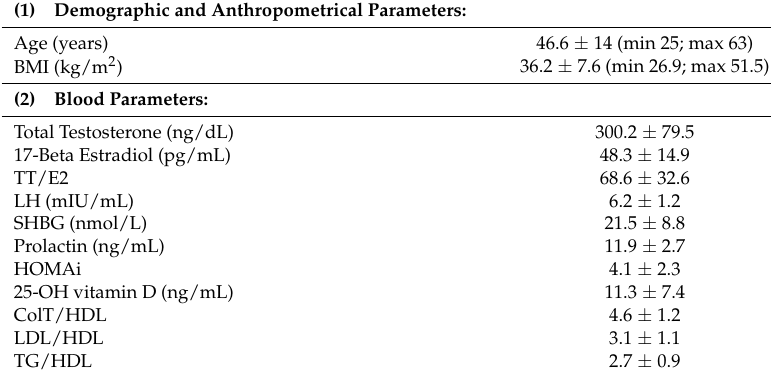
Table 1. Demographic, anthropometrical and blood parameters at